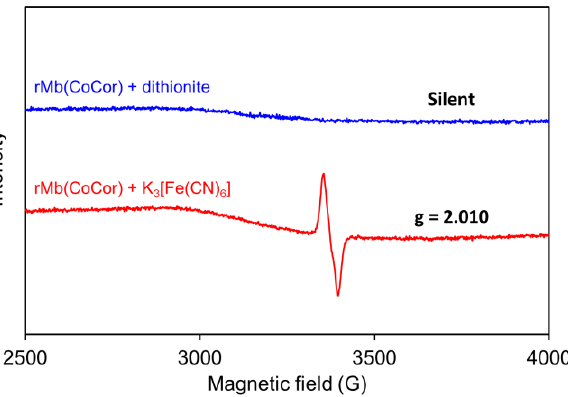
Figure 7. ESR spectra of rMb(CoCor) reduced by dithionite (upper) and rMb(CoCor) oxidized by potassium ferricyanide (bottom). Conditions: [rMb(CoCor)] = 350 μM, [dithionite] = [potassium ferricyanide] = 5 mM in 100 mM potassium phosphate buffer (pH 7.0), MW Power: 2.0 mW, MW Frequency: 9.44 GHz, Mod. Amplitude: 1.0 G, T = 100 K.